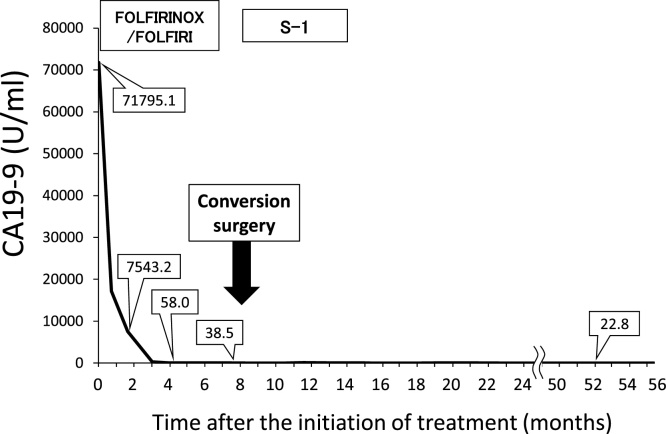
Transition graph of serum carbohydrate antigen 19-9 (CA19-9) level and the treatment progress.